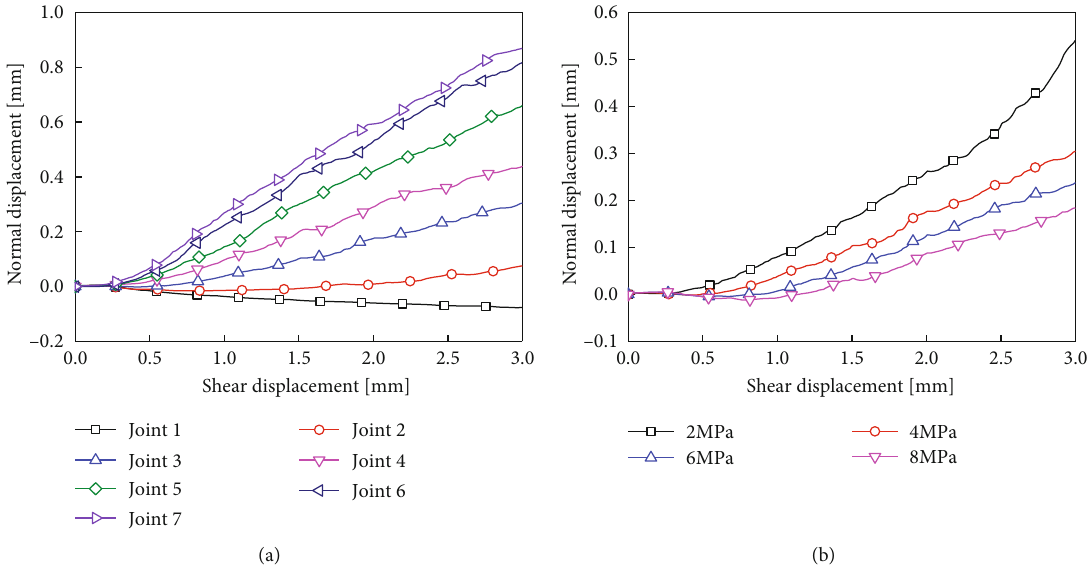
Figure 8: Normal displacement-shear displacement curves of joint samples: (a) in fl uence of roughness at normal stress of 4MPa; (b) in fl uence of normal stresses based on joint